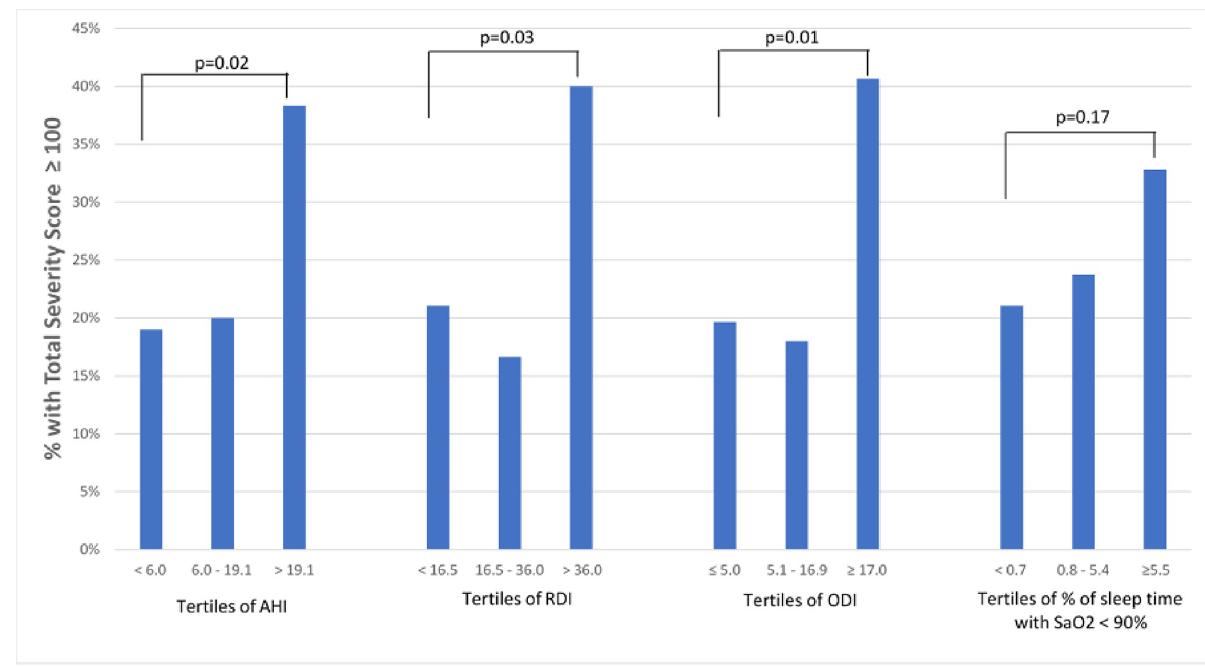
Fig 2. Association of a total severity score � 100, a measure of abnormal myocardial perfusion obtained using positron emission tomography myocardial perfusion imaging, with indicators of obstructive sleep apnea classified in tertiles of their distribution, including the Apnea/ Hypopnea Index (AHI), the Respiratory Disturbance Index (RDI), the oxygen desaturation index (ODI), and the cumulative proportion (%) of sleep spent with oxygen saturation (SaO2) < 90%. P values test the difference between first and third tertile.